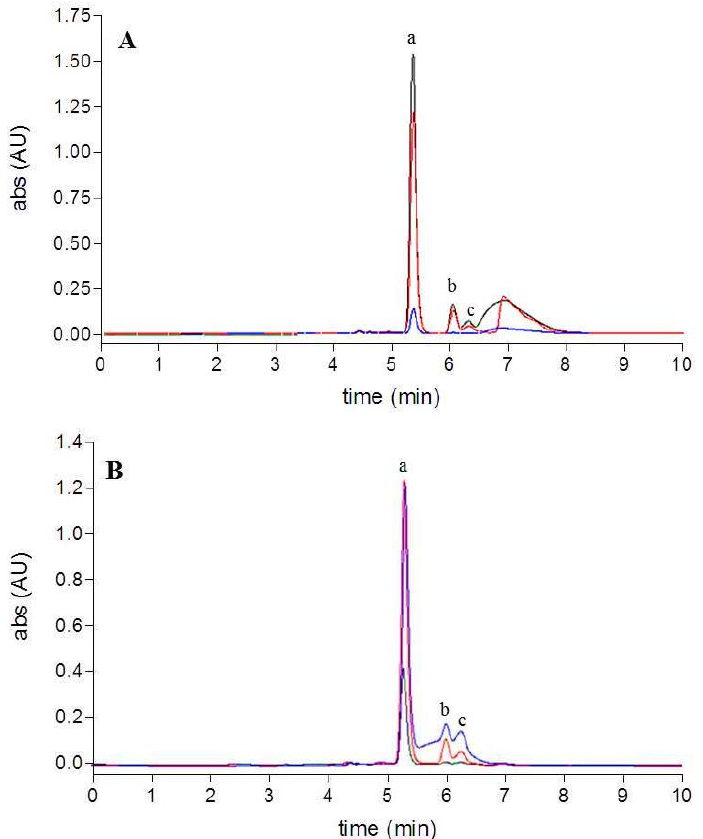
Figure 2. HPLC chromatograms (449 nm): ( A ) conventional extracts (acetone-black, acetonitrile-red, methanol-blue); ( B ) extracts obtained using QuEChERS